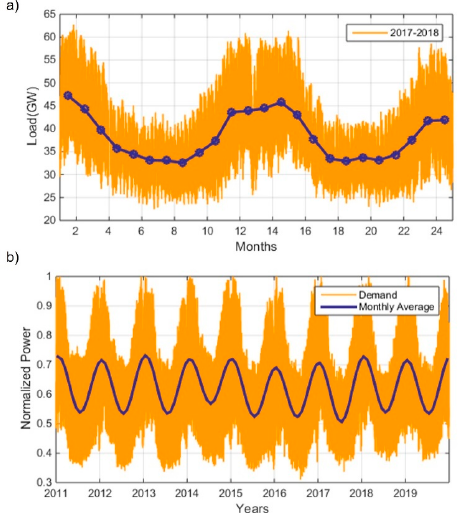
Figure 1. Profiles of electricity demand in the UK: ( a ) in the period 2017–2018; ( b ) normalized historical data. Data from [25,27].